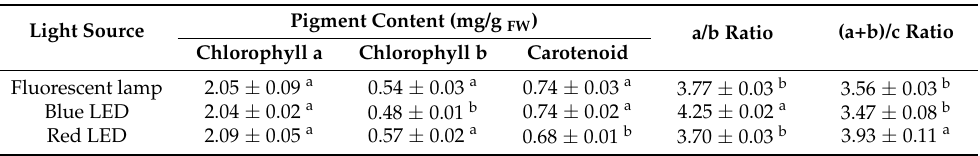
Table 3. The pigments content in leaves of H. corymbosa (L.) Lam after 4 weeks of growth under different light sources at 100 µ mol · m − 2 · s − 1 light intensity.